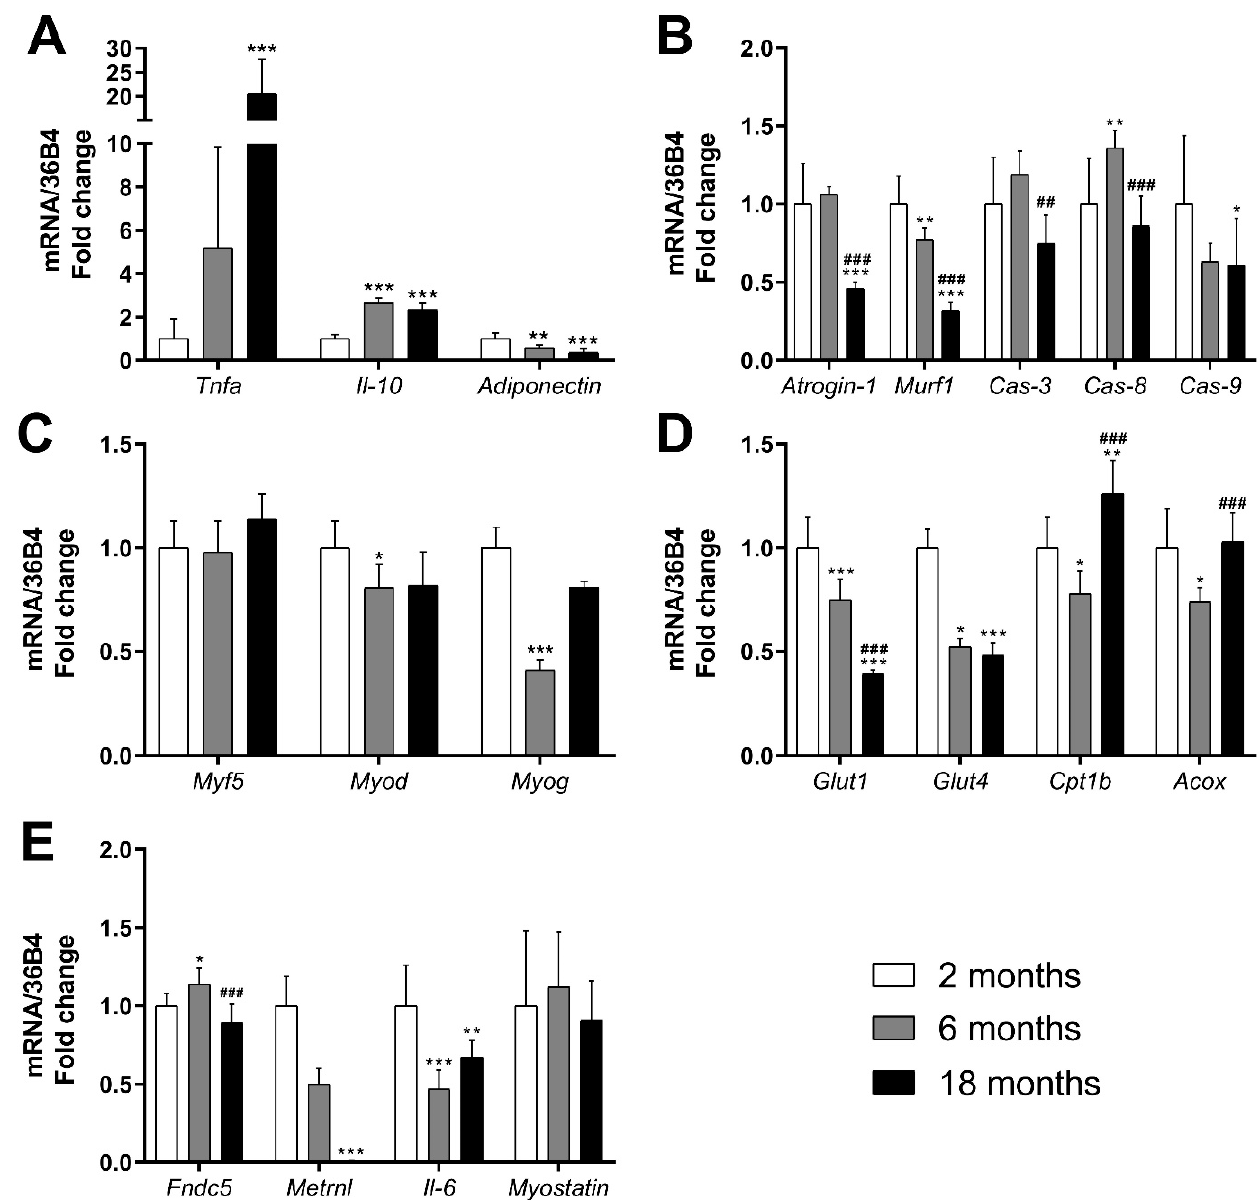
Figure 1. Effects of aging (2, 6 and 18 months) on the mRNA expression of genes related to inflam- mation ( A ), muscle damage ( B ), muscle regeneration ( C ), glucose uptake and fatty acid oxidation ( D ) and myokine expression ( E ) on the gastrocnemius muscle of C57BL/6J female mice fed a standard diet. Data presented as mean (SD); n = 7–10. * p < 0.05, ** p < 0.01, *** p < 0.001 vs. 2-month-old mice; ## p < 0.01, ### p < 0.001 vs. 6-month-old mice.